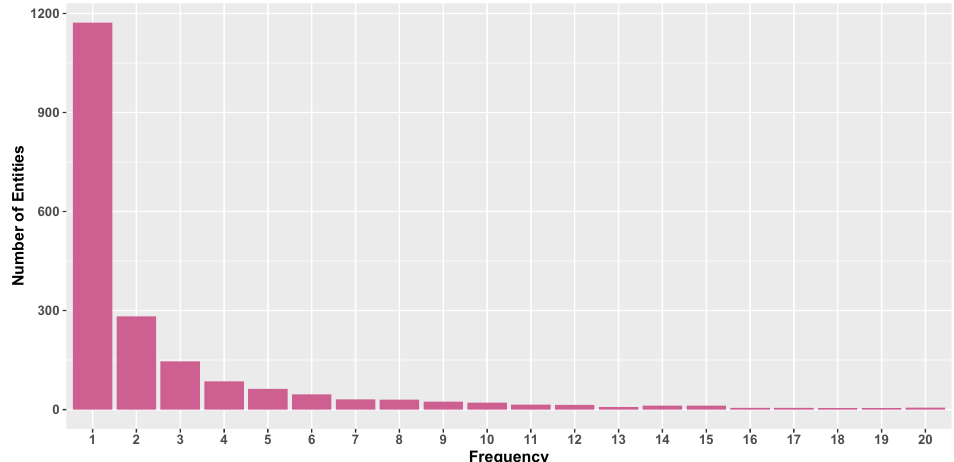
Figure 2. Number of food entities in the FoodBase corpus depending on their occurrence frequency. This figure limits the frequency to 20 for clarity because the maximal frequency is